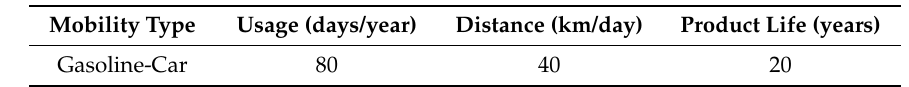
Table 12. User phase inputs for car usage.